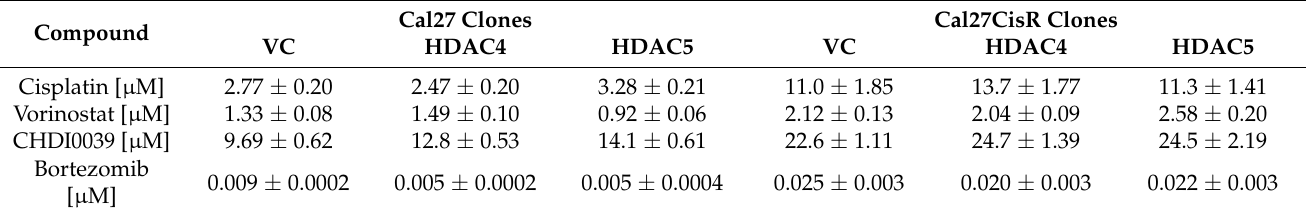
Table 3. Cytotoxic activity (MTT assay) of vorinostat, CHDI0039, bortezomib, and cisplatin at Cal27 and Cal27CisR vector control (VC) and HDAC4 and HDAC5 overexpression clones after compound incubation for 72 h. Shown are IC 50 values ± SD of at least three independent